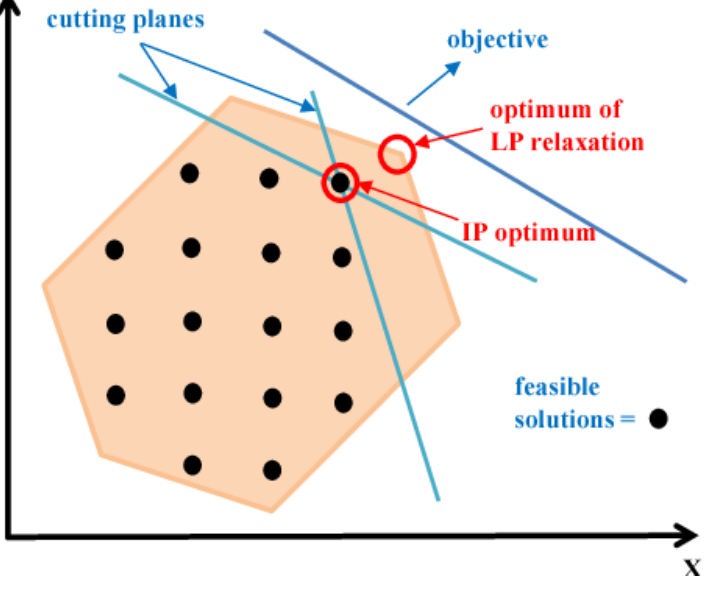
Figure 6. Cutting-plane